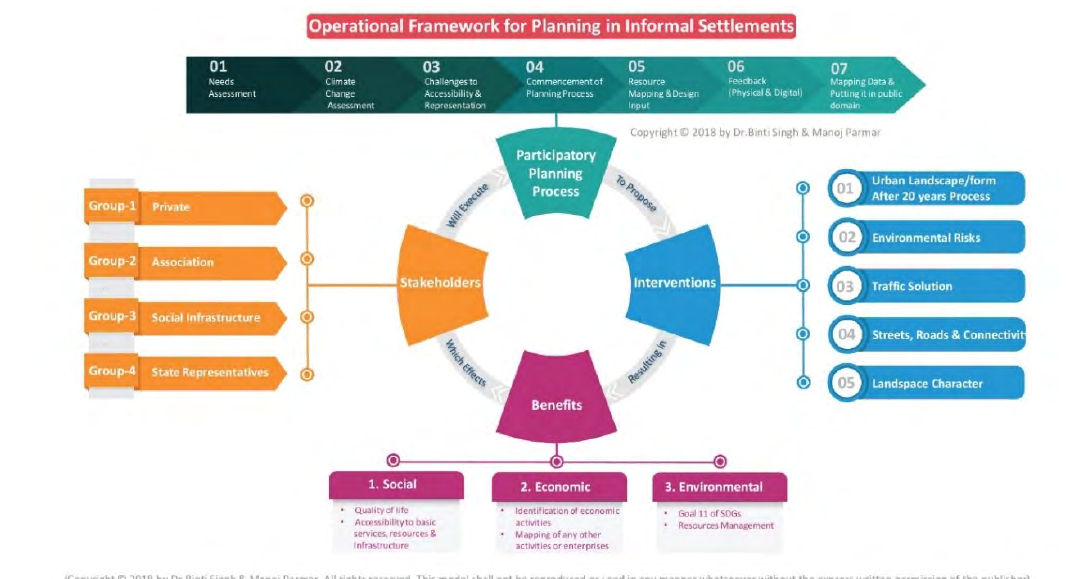
Figure 7. Operational Frmework for Planning in